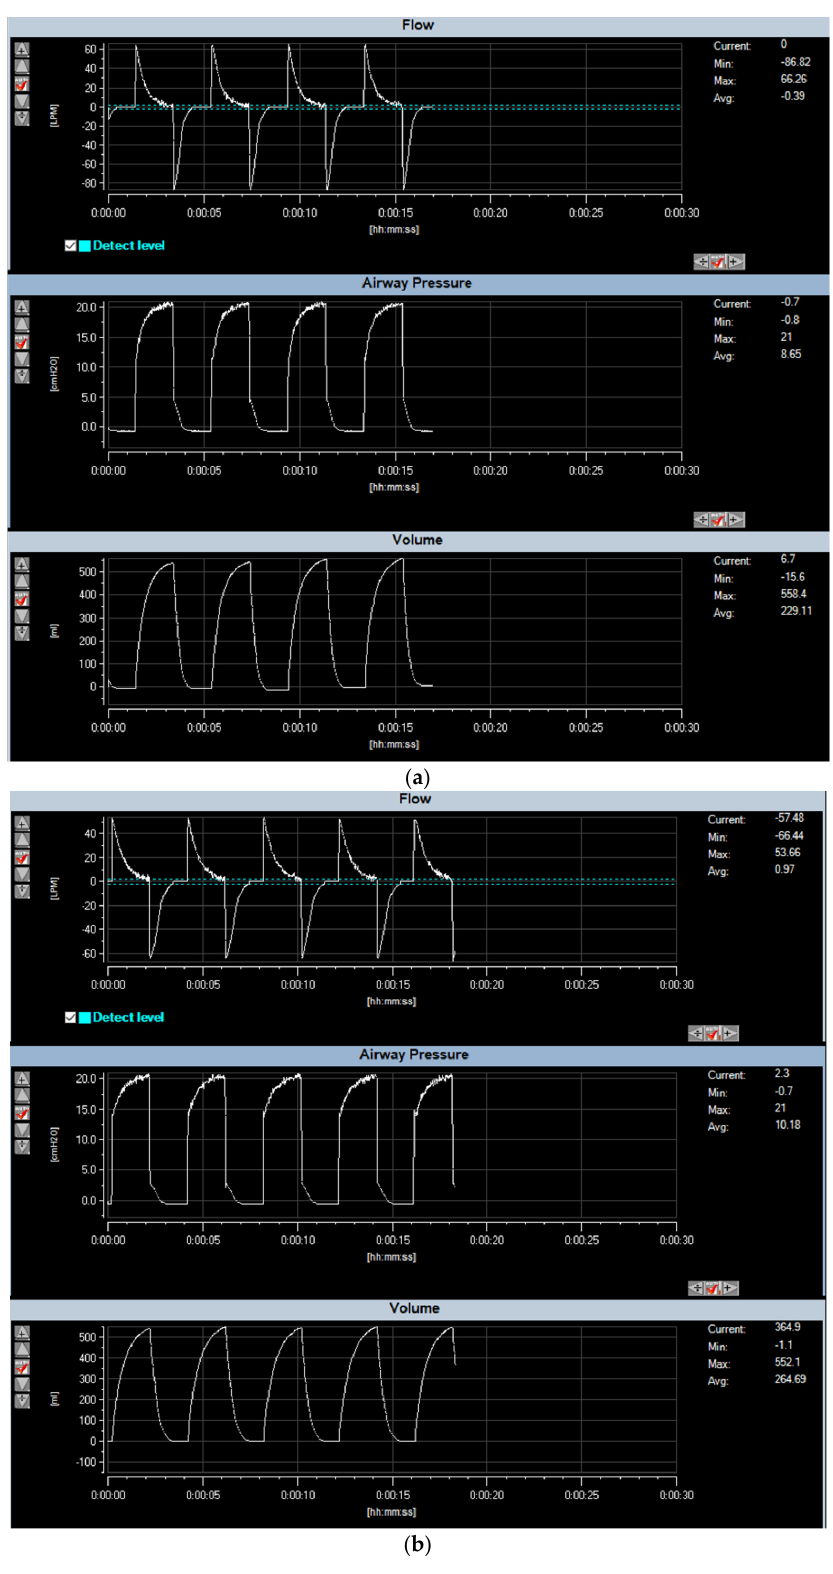
Figure 19. Performance test using VT Plus Hi Flow Ventilator analyzer and SmartLung 2000: ( a ) lung resistance of 5 mbar/L/s and lung compliance of 0.025 L/mbar; ( b ) lung resistance of 5 mbar/L/s and lung compliance of 0.060 L/mbar. The characteristics of graph flow, pressure, and volume are compatible to the simulation